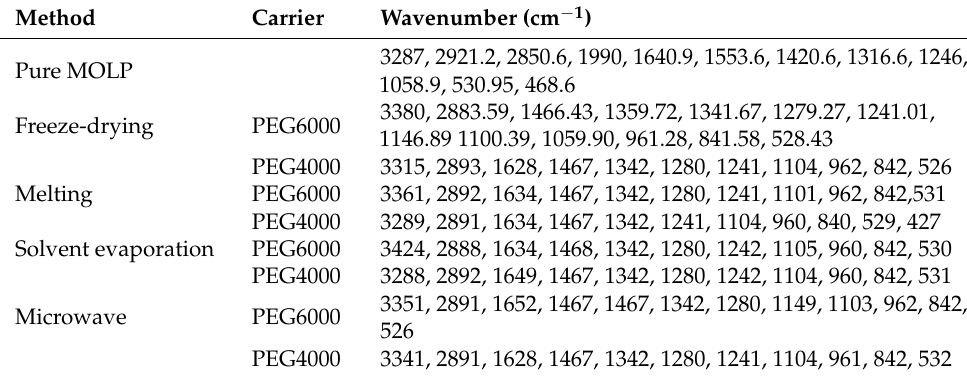
Table 3. Functional groups from the FTIR spectra of MOLP, PEG, and solid dispersions 1 .